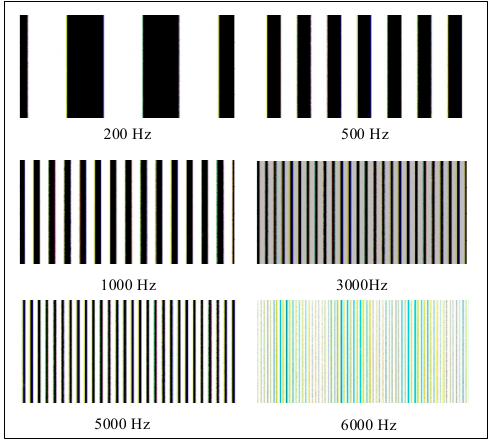
Figure 5. Captured LED images for various transmitted frequencies.